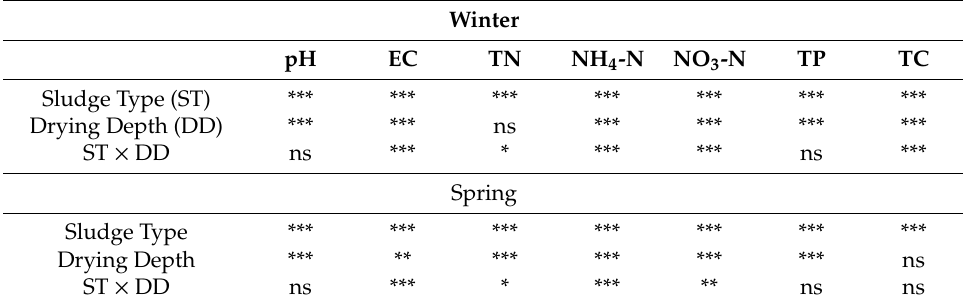
Table 1. Analysis of variance for the measured parameters during the study in winter and spring drying phases as influenced by factors (sludge type and drying depth) and their